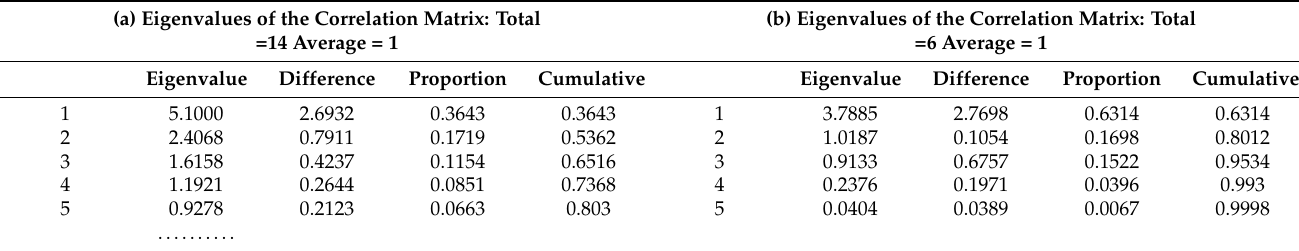
Table 3. Eigenvalues and variance explained by the first five principal components (PCs) of the analysis carried out on the set of ( a ) chemical and biological indicators (14 variables) and ( b ) physical indicators (6 variables). (a) Eigenvalues of the Correlation Matrix: Total (b) Eigenvalues of the Correlation Matrix: Total =14 Average = 1 =6 Average = 1 Eigenvalue Difference Proportion Cumulative Eigenvalue Difference Proportion